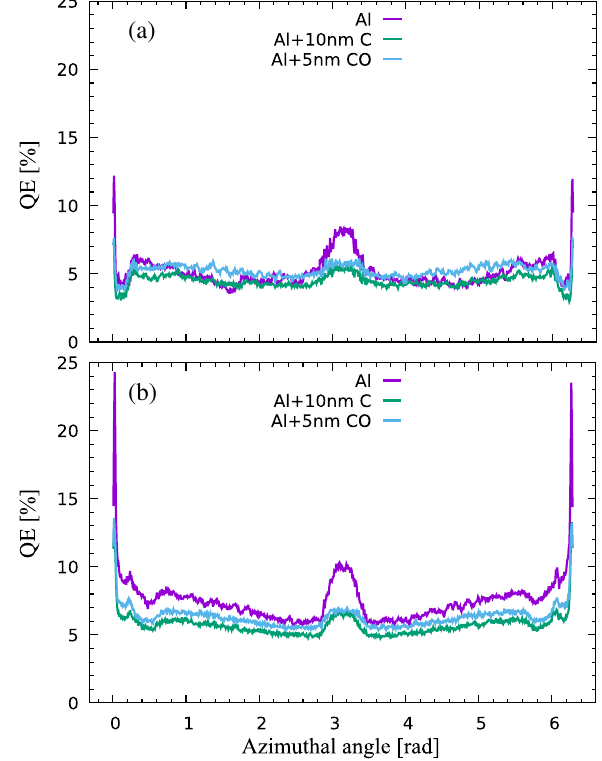
FIG. 18. Azimuthal dependence of quantum efficiency for (a) field-free regions and (b) dipole regions of the CESR ring for aluminum and aluminum with a carbon or carbon monoxide layer. (Beam energy is 5.3 GeV.)